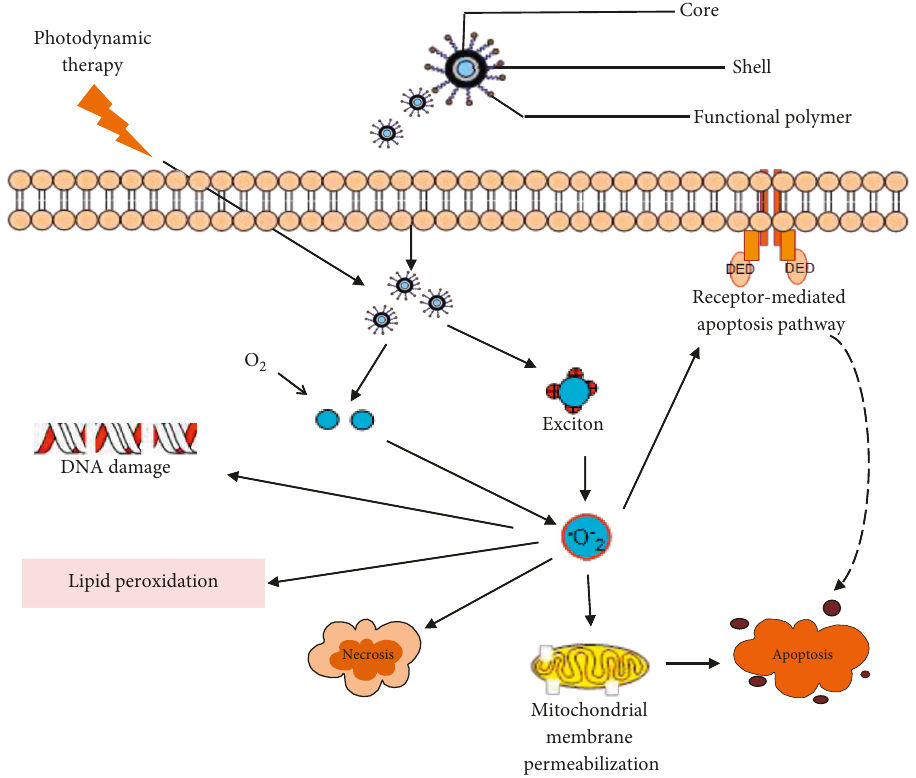
Figure 7: Anticancer mechanisms of semiconductor quantum